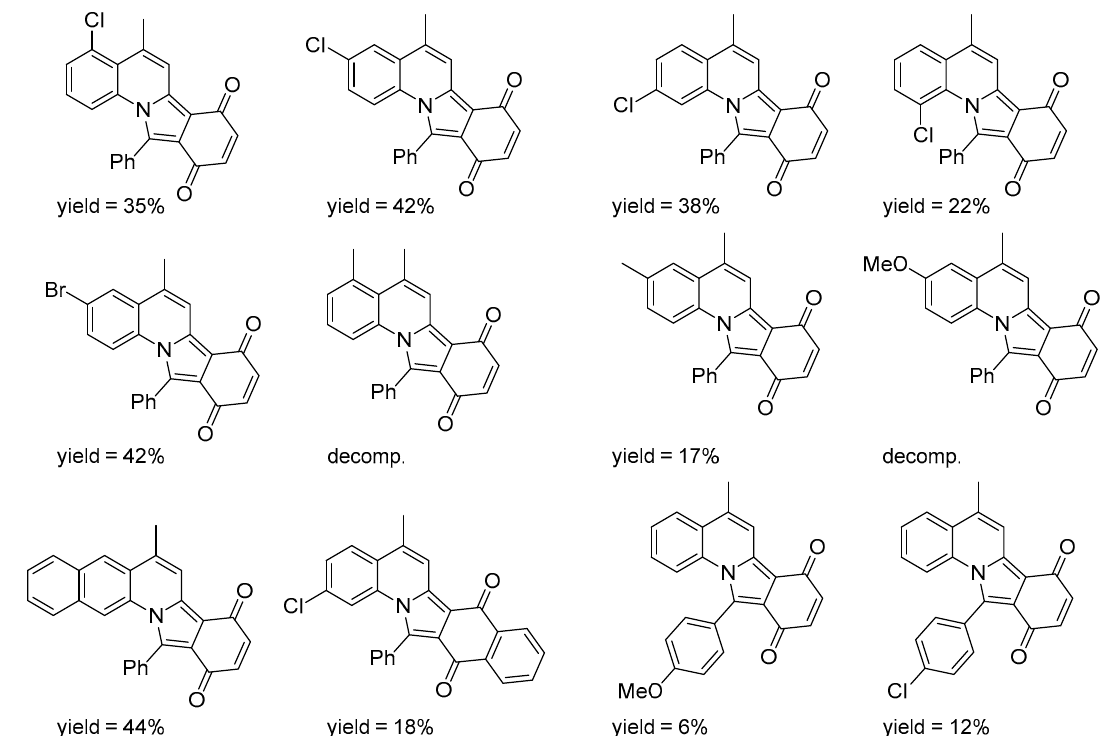
Figure 2. Scope of products obtained by one-pot RCM/oxidation/1,3-dipolar cycloaddition proto- col.